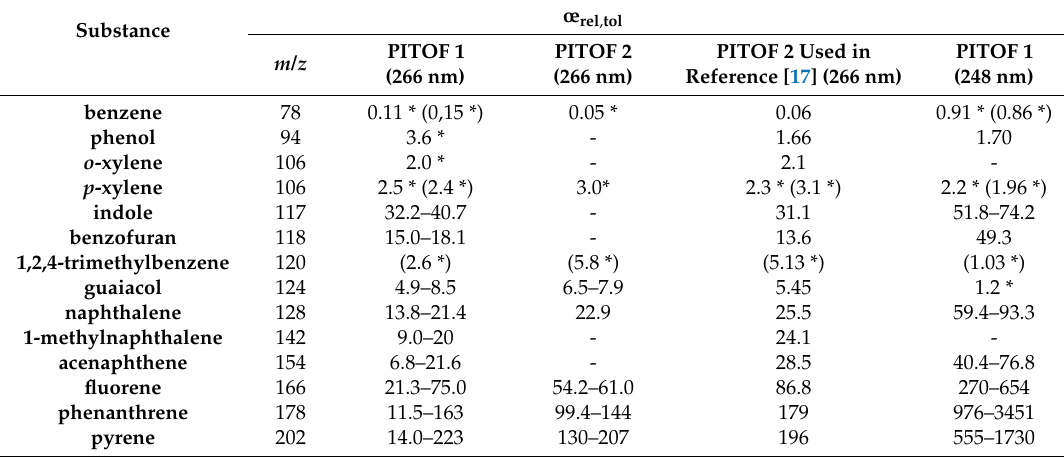
Table 1. Overview of relative REMPI cross sections ( σ rel,tol ; toluene was used as a reference substance) at 266 nm and 248 nm obtained using different mass spectrometric systems. œ rel ,